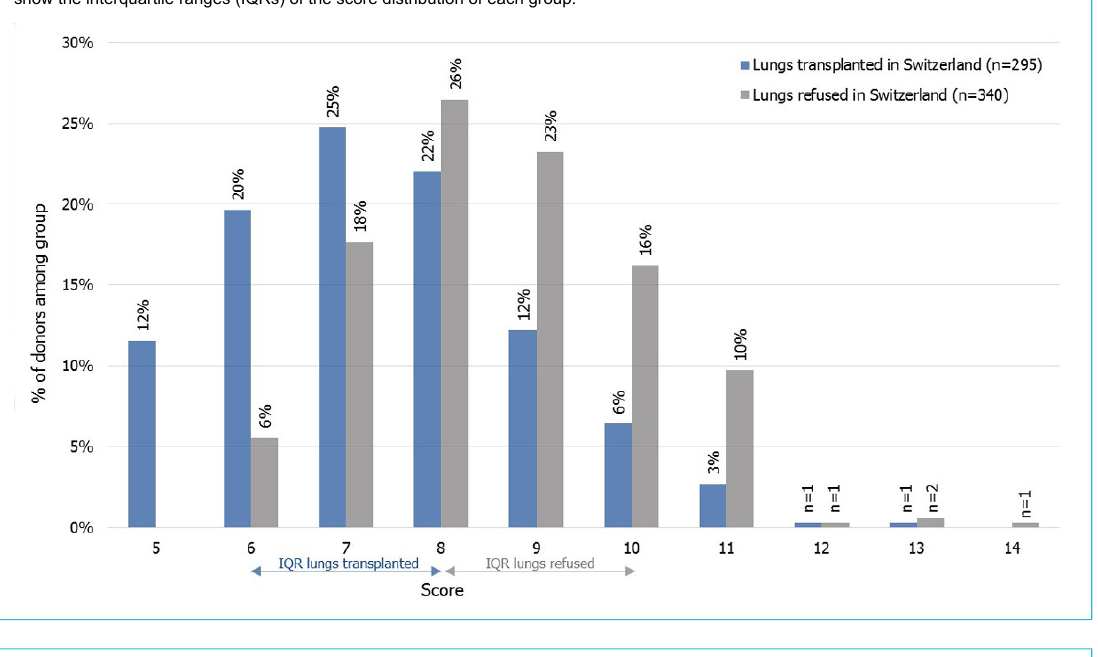
Figure 3: Adapted Zurich donor score for accepted lung donors (blue) vs refused lung donors (grey). Arrows show the interquartile ranges (IQRs) of the score distribution of each group.